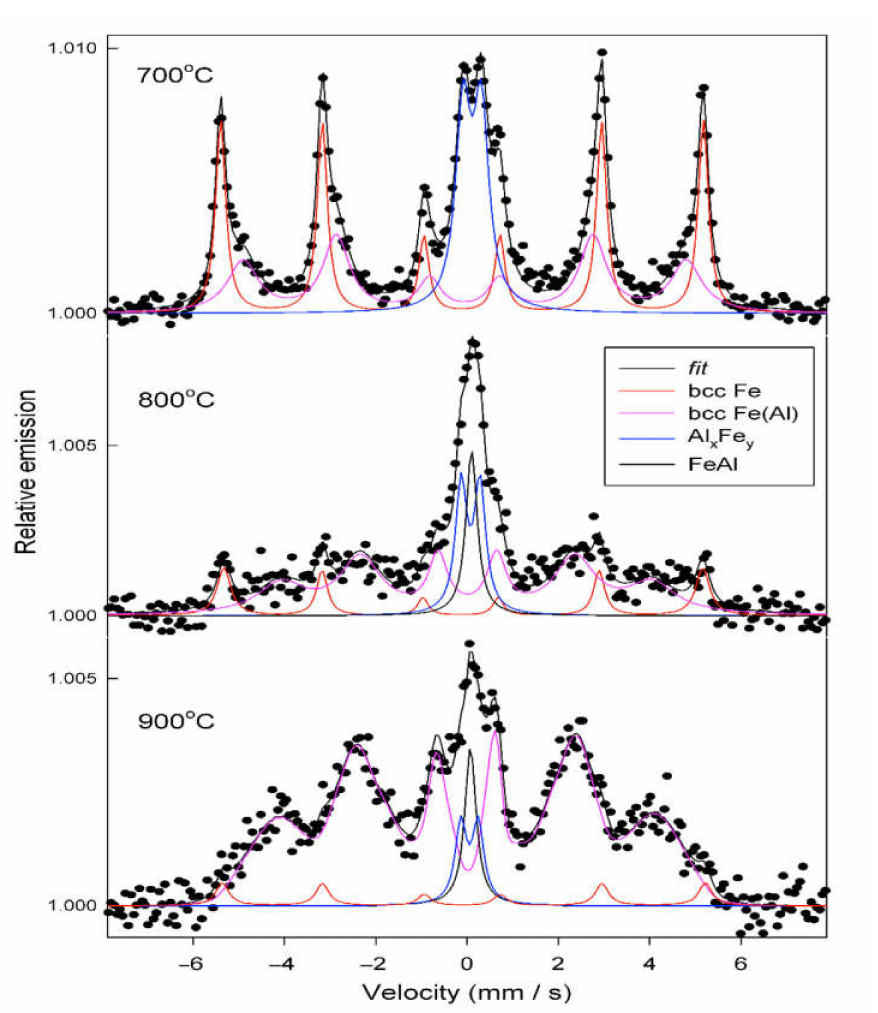
Figure 12. Conversion electron Mössbauer spectra of the coatings annealed at 700–900 ◦